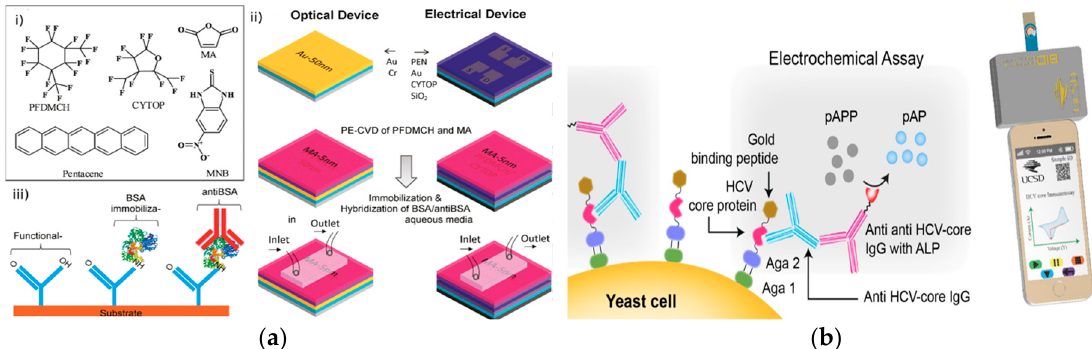
Figure 6. ( a ) (i) Organic molecule chemical structures. (ii) Schematic of the fabrication process of an Organic Thin Film Transistor (OTFT) with source-drain gold electrode, dielectric layer, and pentacene layer for passivation and functionalization of the OTFT surface. (iii) Schematic of the sensor to selectively detect anti-BSA. (Adapted with permission from Ref. [52]. Copyright © 2014 American Chemical Society.) ( b ) Schematic of the expressed HCV core protein bound to HCV-core IgG antibody, with electrochemical detection of the anti-HCV-core IgG antibody through the reaction of p-aminophenyl phosphate (pAPP) with alkaline phosphatase (ALP). (Adapted from Ref. [54]. Copyright © 2016 Elsevier B.V.)